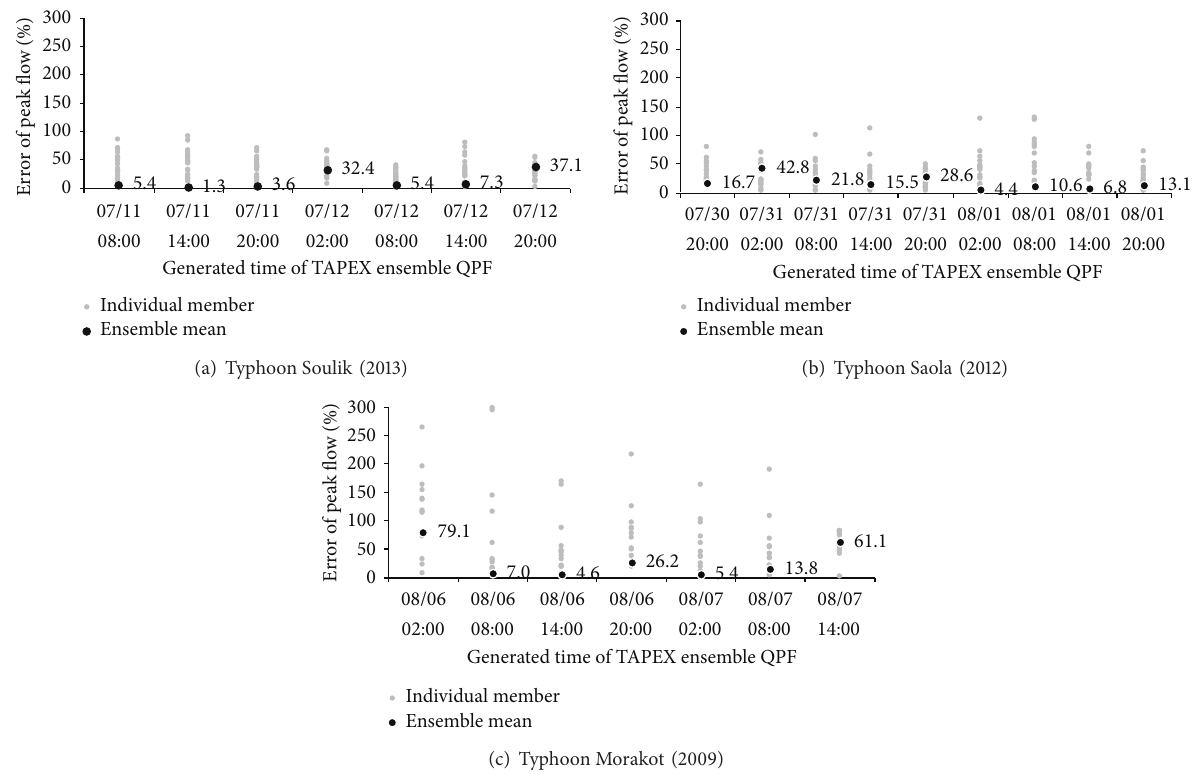
Figure 7: The error of peak flow forecast in magnitude. The averages of the ensemble-mean forecast error were 13.2, 17.8, and 28.2 percent.